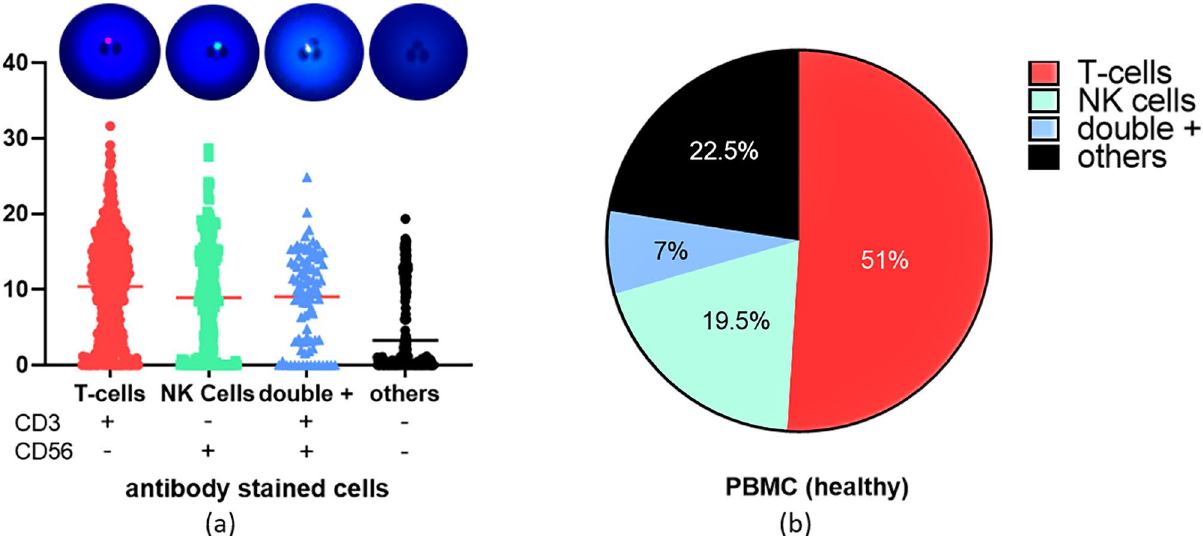
Figure 7. Single cell fluorometric granzyme B activity assay for PBMC cells from healthy person ( a ) antibody staining shows the immune cell composition and corresponding activity (red line indicates the mean value) ( b ) percent composition of immune cells in the profiled sample. Graph created using GraphPad Prism